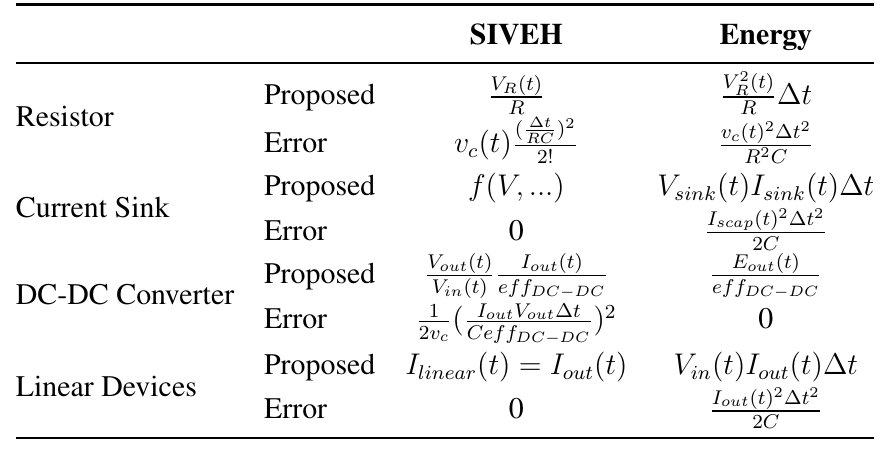
Table 1. Simulator I–V for EH (SIVEH) and energy models of the basic circuit